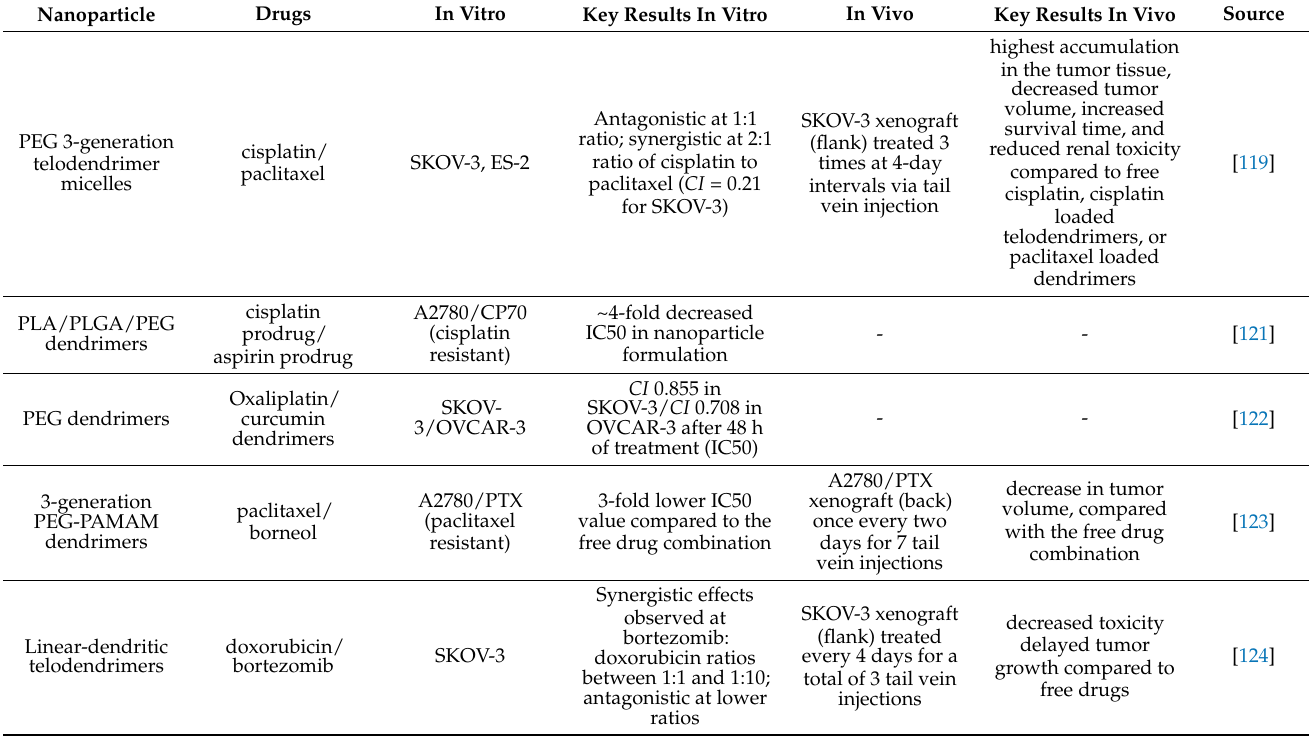
Table 5. Dendrimer based nanocarriers for co-delivery of anticancer